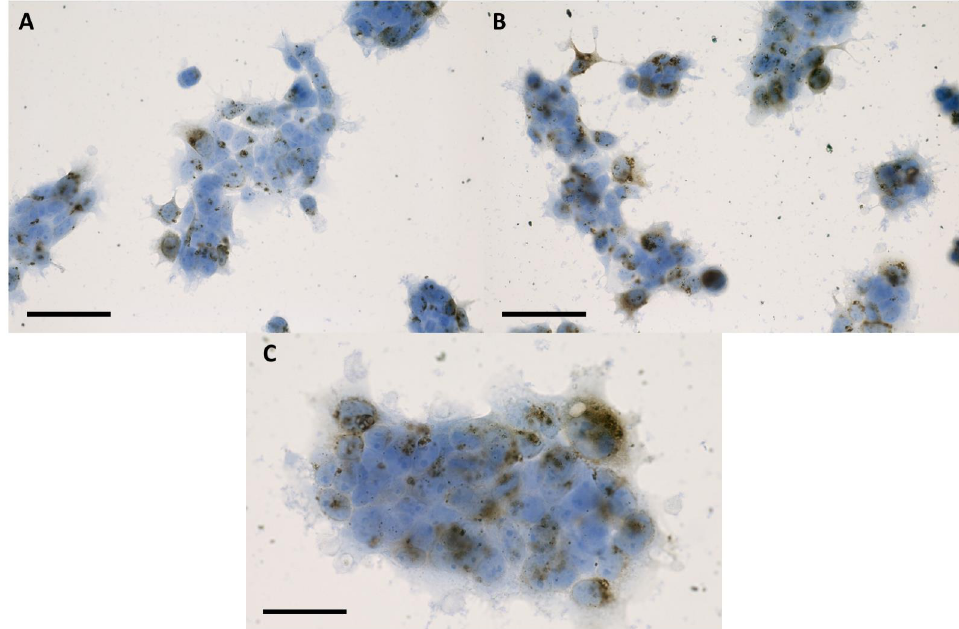
Figure 2. Bright-field microscopy images of human squamous cell carcinoma (FaDu) at 24 h following 16 h of incubation with 100 μg/mL ( A ), and 200 μg/mL ( B ) IONP DOX ; blue hematoxylin, dark brown IONP; the measure bar is 50 μm; ( C ) detailed image of FaDu cells at 24 h following 16 h of incubation with 200 μg/mL IONP DOX ; the scale bar is 25 μm.